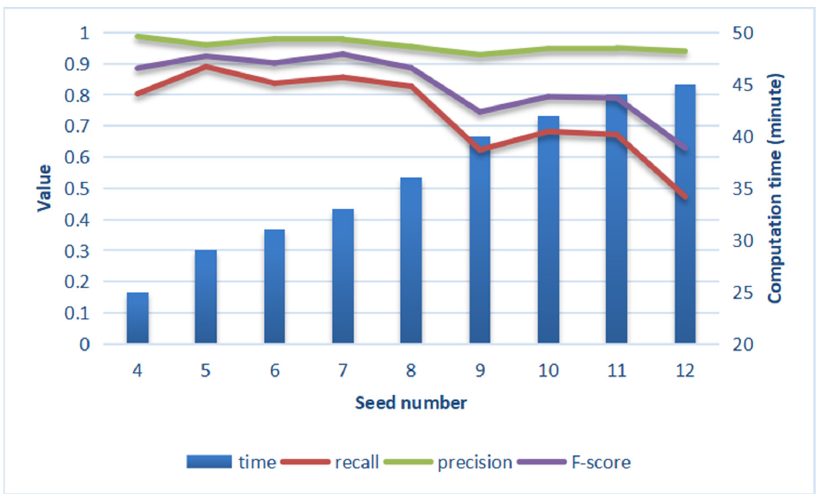
time with the variation of the parameter radius.